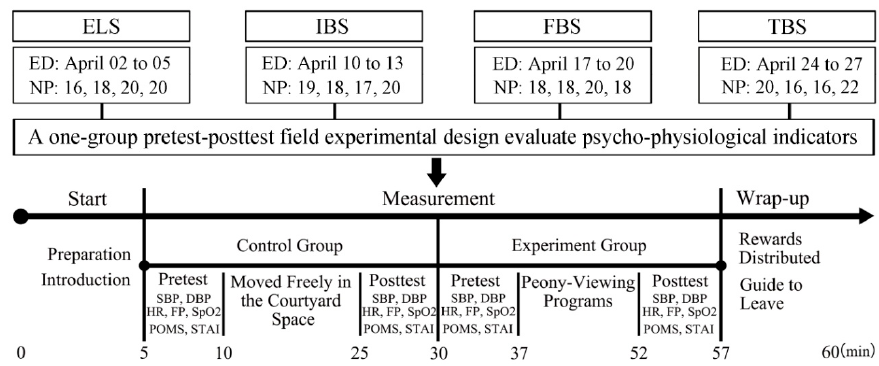
Figure 3. Sequence and contents of associated experimental events. ED: experimental date, NP: number of participants, ELS: exhibition leaf stage, IBS: initial bloom stage, FBS: full bloom stage, and TBS: terminal bloom stage. All subjects were examined individually.